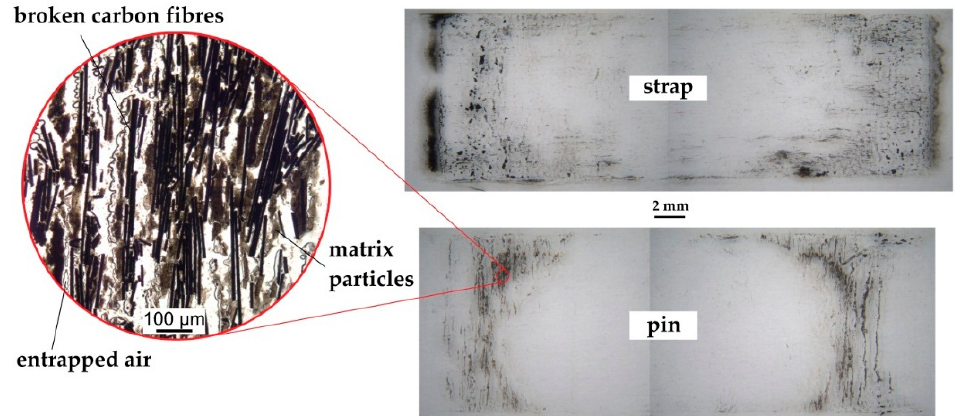
Figure 7. Fretting products of a strap after 3 × 10 4 load cycles ( top ) and a pin after N = 10 6 ( bottom ). Both images show fretting products from tests conducted at a load level of 720 MPa. The different wear mechanisms on a strap and pin are clearly visible.